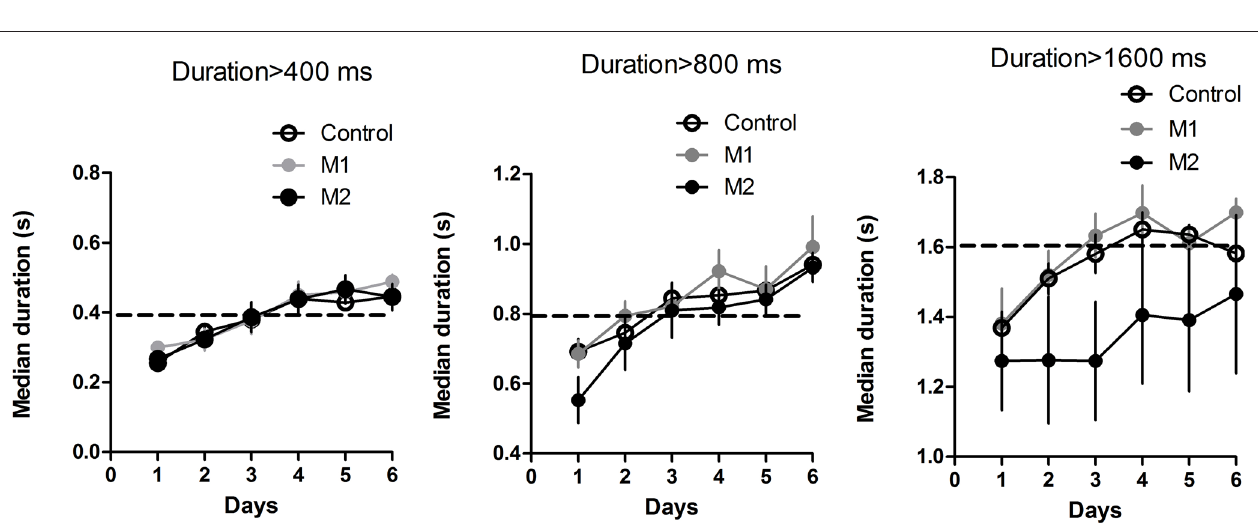
FIgure  | Median press durations during temporal